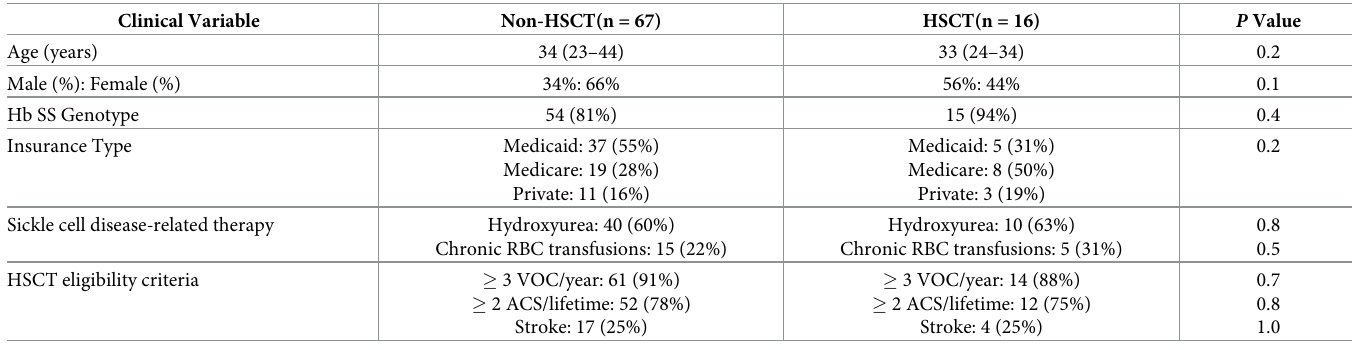
Table 1. Baseline characteristics of patients with sickle cell disease that underwent hematopoietic stem cell transplantation (HSCT) vs. continued standard care. Clinical